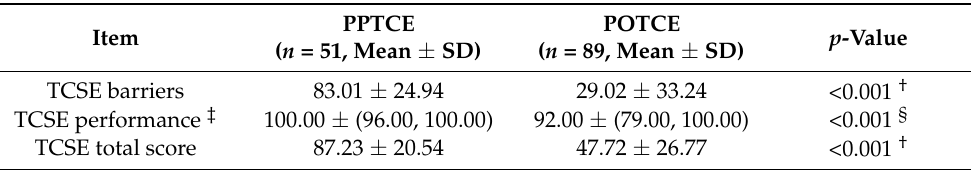
Table 4. Known-group comparisons between participants with prior Tai Chi experience and those without prior Tai Chi experience ( n =